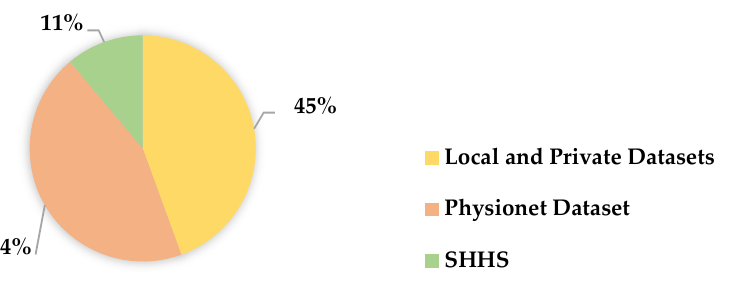
Figure 4. Percentage distribution of different databases.